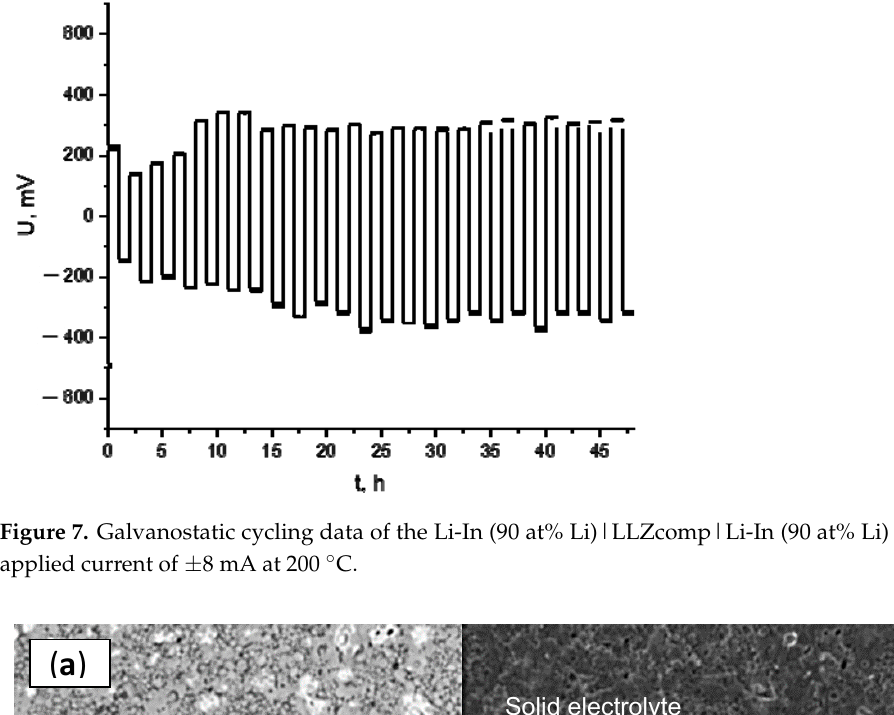
Figure 7. Galvanostatic cycling data of the Li-In (90 at% Li) | LLZcomp | Li-In (90 at% Li) cell with applied current of ±8 mA at 200 °C.